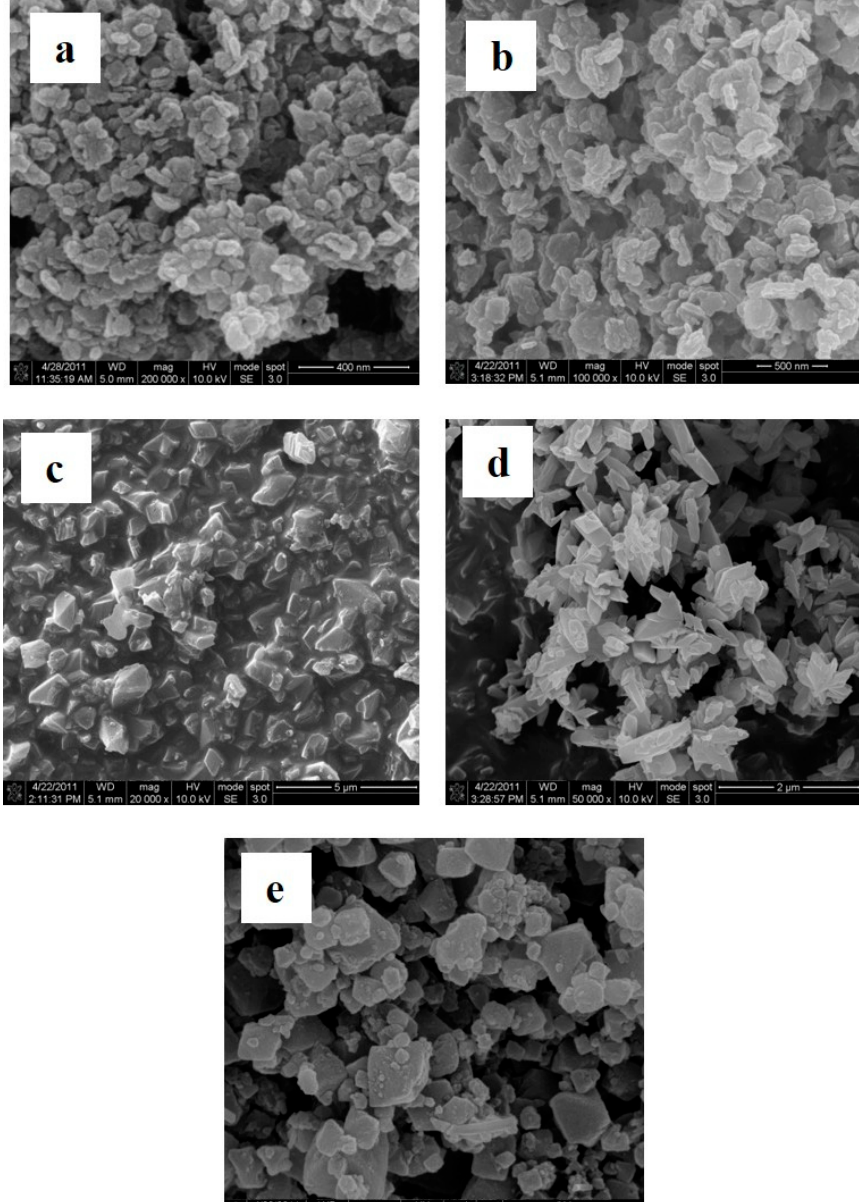
Figure 2. The SEM images for MW-synthesized MOFs of: ( a ) DUT-4; ( b ) DUT-5; ( c ) MIL-53; ( d ) NH 2 -MIL-53; and ( e ) MIL-100. Table 1. Particle size values of Al-MOFs synthesized by MW and CE method.